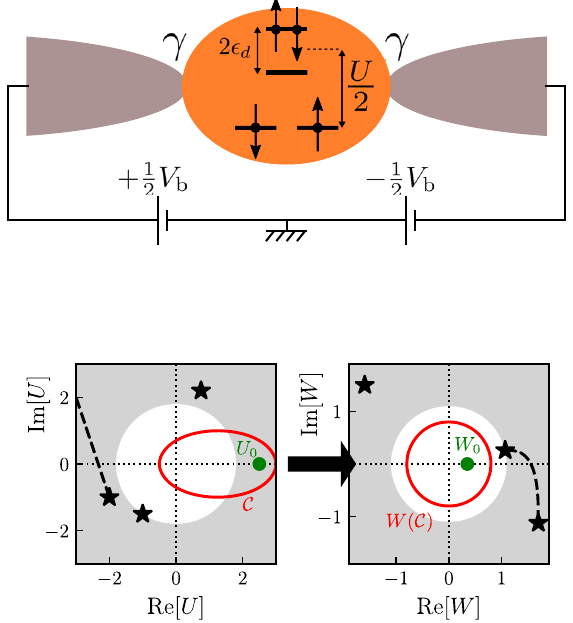
FIG. 1. Top: The Anderson quantum impurity model describing a single-level quantum dot. The level with energy ϵ a finite Coulomb interaction U and is hybridized with a tunnel coupling γ to two leads that are biased with voltage V Illustration of the general computation scheme developed in this work. A physical quantity F (e.g., the current through the dot) presents singularities in the U complex plane (left), such as poles (stars) or branch cuts (dashed line), hampering the proper convergence of perturbative approaches for values of U outside the convergence disk (gray area). After defining a broad singu- larity-free contour C (red line) that encircles both U ¼ 0 and a targeted U 0 value, a conformal map U → W ð U Þ is defined in order to bring W 0 ¼ W ð U 0 Þ inside the convergence disk of F ½ U ð W Þ(cid:2) (right). Resummation techniques can then be applied in a controlled